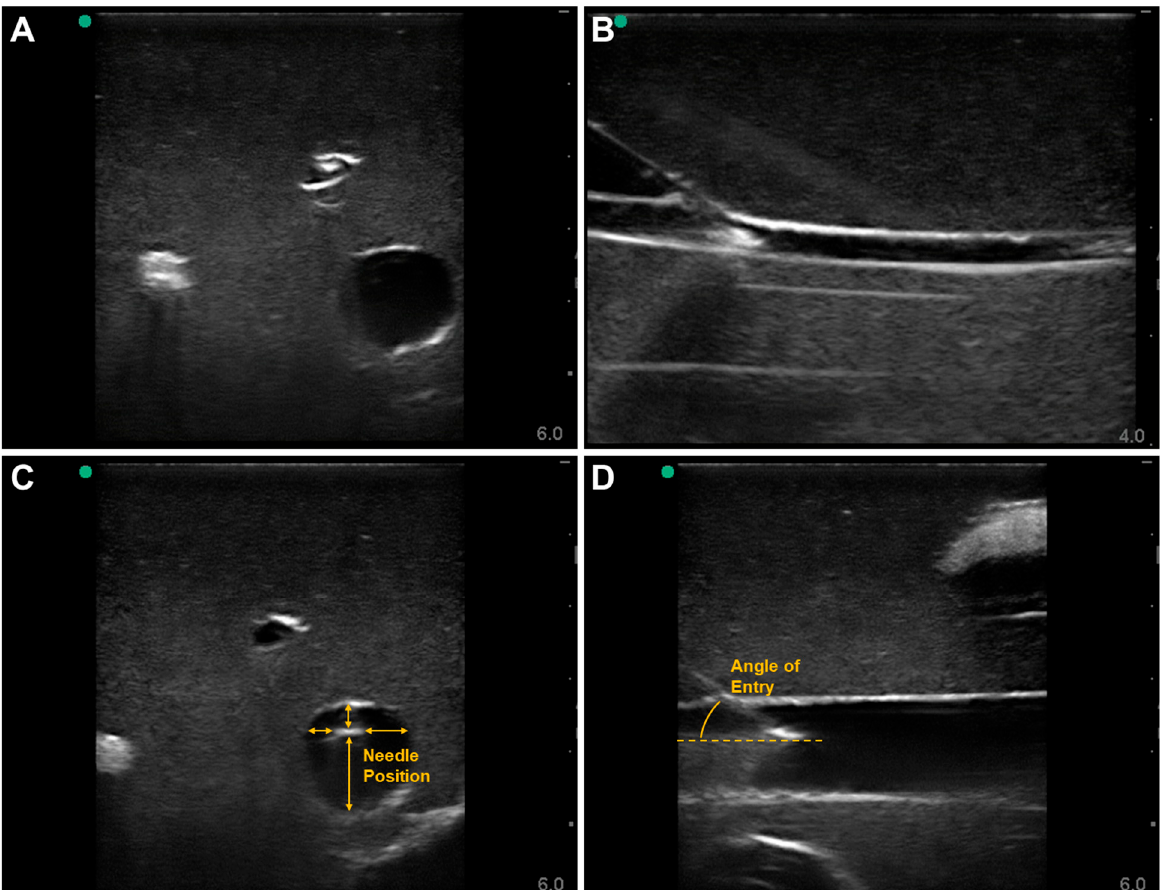
Figure 2. Commercially available Blue Phantom Gen II Vascular Access model with out-of-plane ( A ) and in-plane ( B ) views of arterial needle insertion and out-of-plane ( C ) and in-plane ( D ) views of venous needle insertion. Measurements were overlayed in the ultrasound images ( C , D ) for how key performance metrics can be collected from the ultrasound